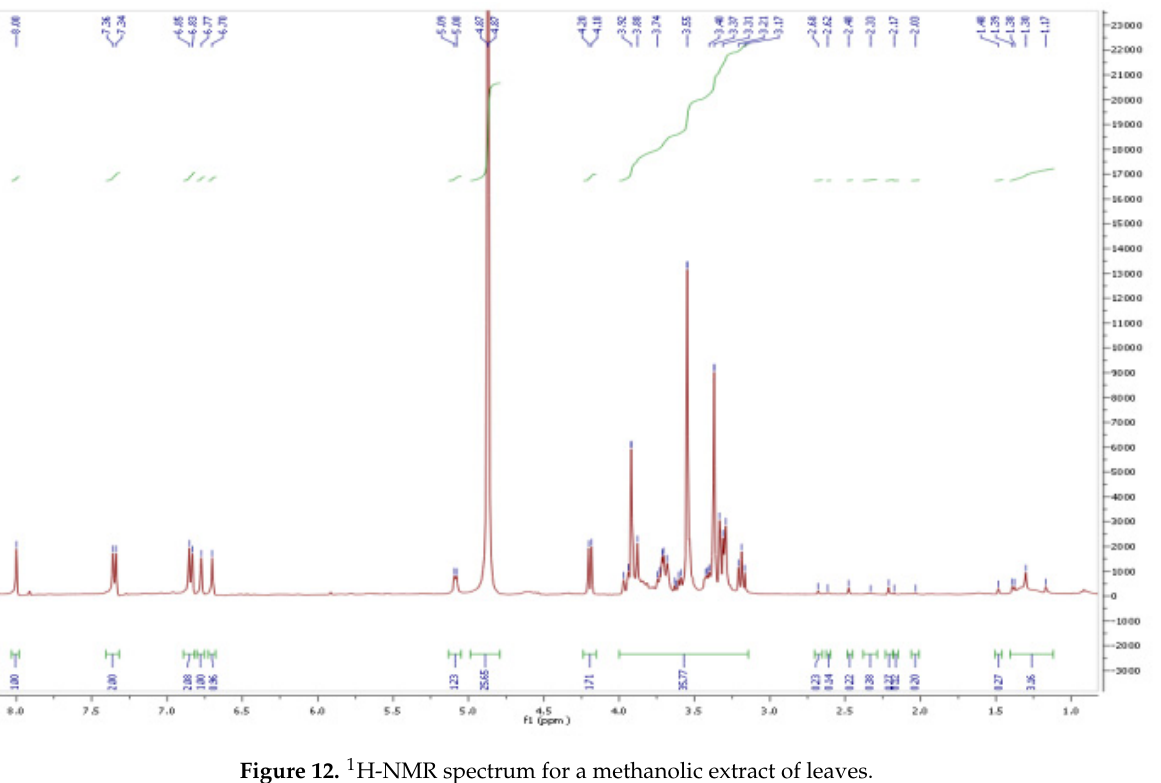
Figure 12. 1 H-NMR spectrum for a methanolic extract of leaves.